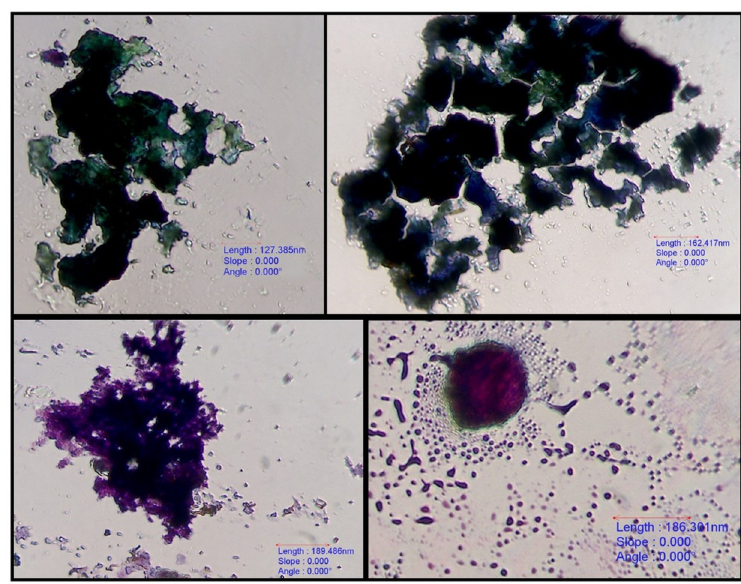
Fig 1. Purple to black amorphous aggregates. 40x. Diff-Quik stain, euromex CMEX 5 microscope camera.